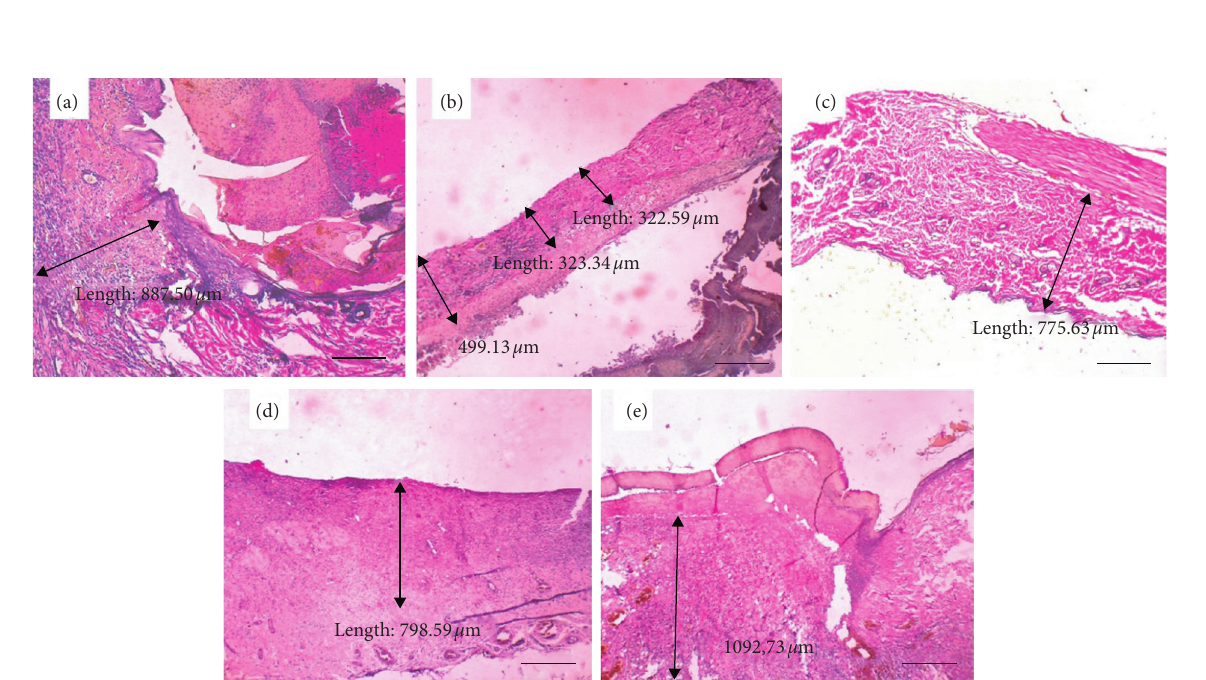
Figure 3: The thickness of collagen on day 3. (a) Control group with nonozonated Aloe vera oil. (b) Control group with gentamicin application. (c) Treatment group with 600mg ozonated Aloe vera oil. (d) Treatment group with 1,200mg ozonated Aloe vera oil. (e) Treatment group with 1,800mg ozonated Aloe vera oil. Scale bar 100 μ